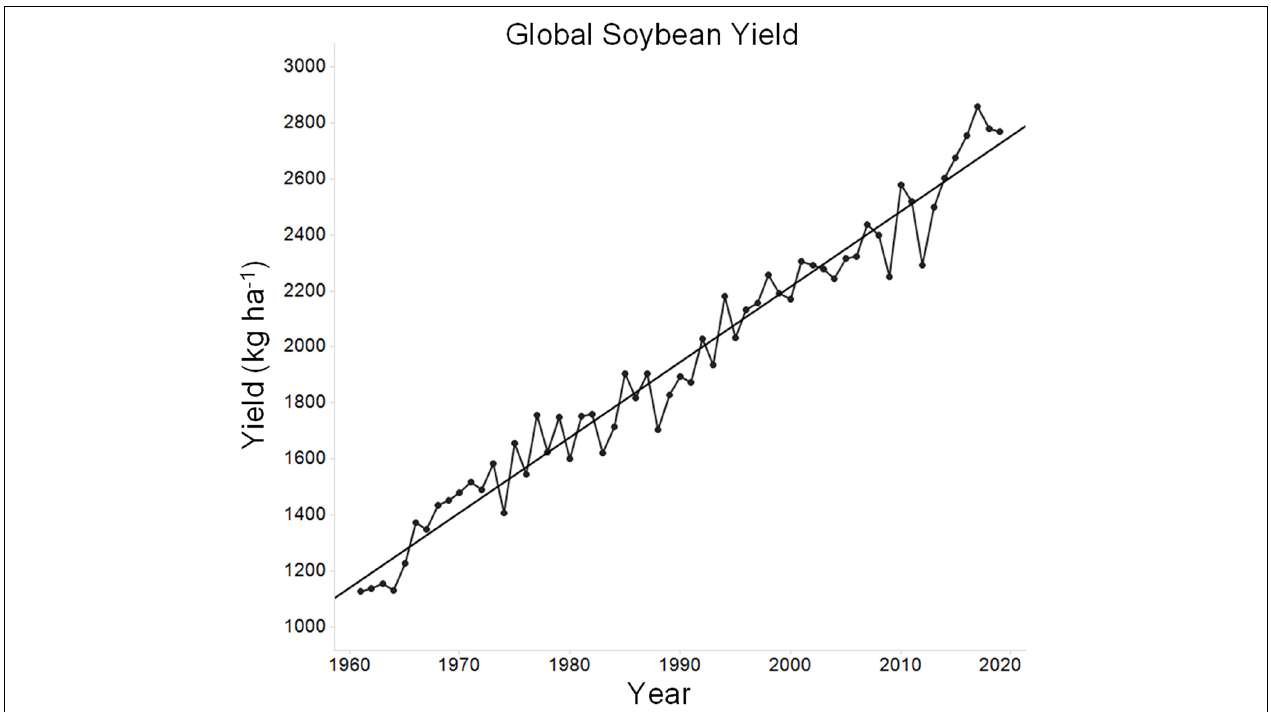
FIGURE 1 | Average global soybean yield over time. Data for average historic global soybean yield was sourced from the UN Food and Agriculture Organization (FAO) database in September 2021 (http://www.fao.org/faostat/en/#data). The figure depicts average soybean yield over time and a regression line was plotted for